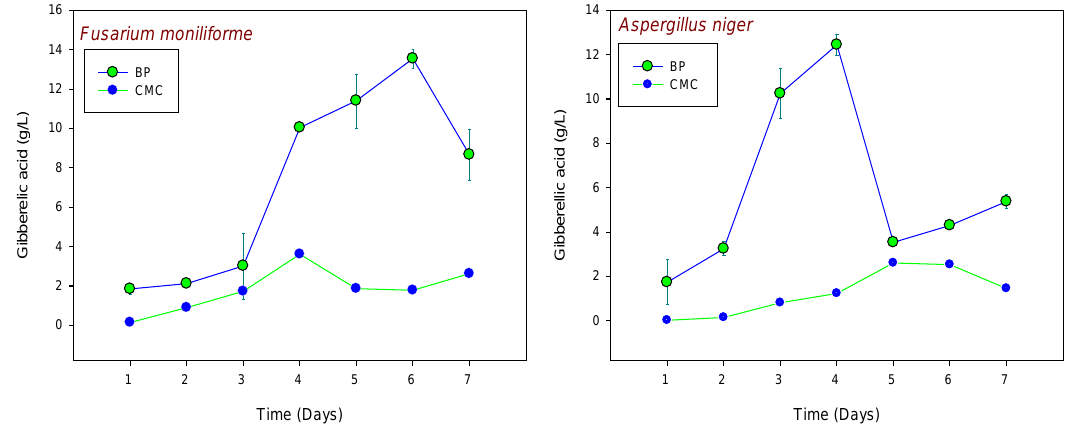
Fig. 1. Effect of varying fermentation time on gibberellic acid production by F. moniliforme and A. niger using banana peel as substrate